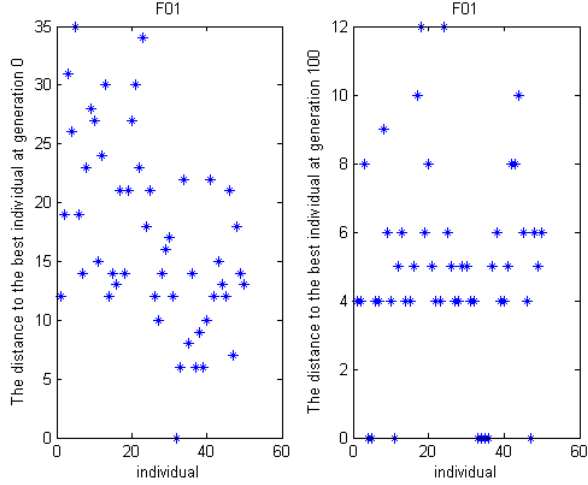
Mathematics 2018 , 6 , x FOR PEER REVIEW Figure 12. The distribution graph of fitness on MSO4 for T01. Figure 12. The distribution graph of fitness on MSO4 for T01. Figure 12. The distribution graph of fitness on MSO4 for T01.